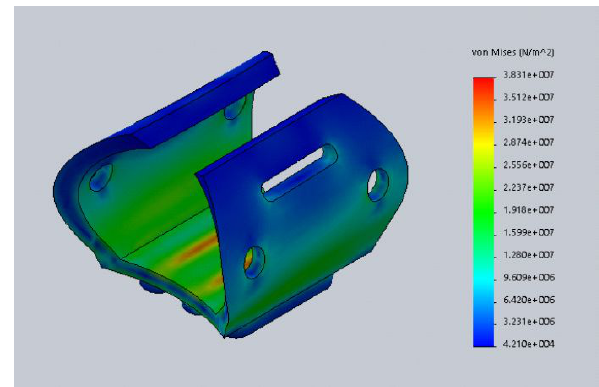
Figure 7: First design prepared and simulated for the lower arm